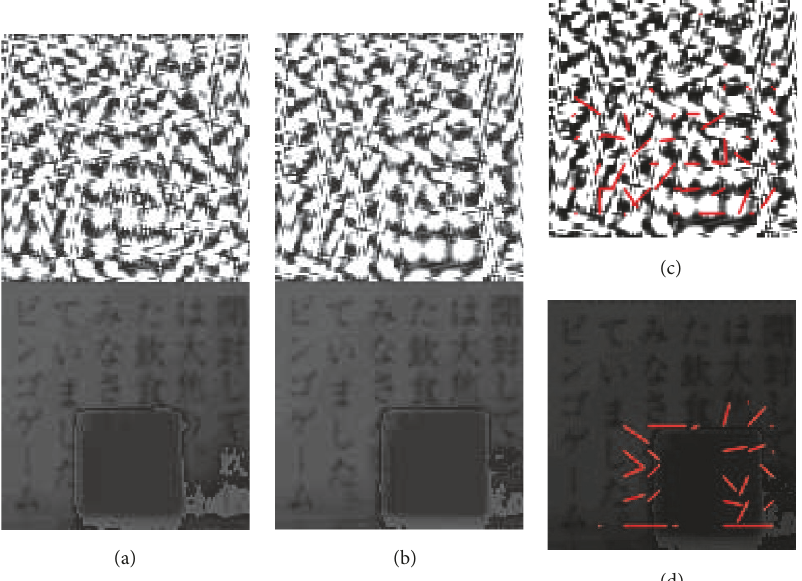
Figure 5: Real-time extraction of RD patterns of a textureless object moving over a text background and subsequent estimation of the corresponding motion vector field. (a) First acquired frame and corresponding RD pattern; (b) second acquired frame and corresponding RD pattern. (c) Close-up of the RD pattern obtained from the second acquired frame with overlaid motion vectors and (d) close-up of the second acquired frame with overlaid motion vectors that are acquired using a conventional block-matching